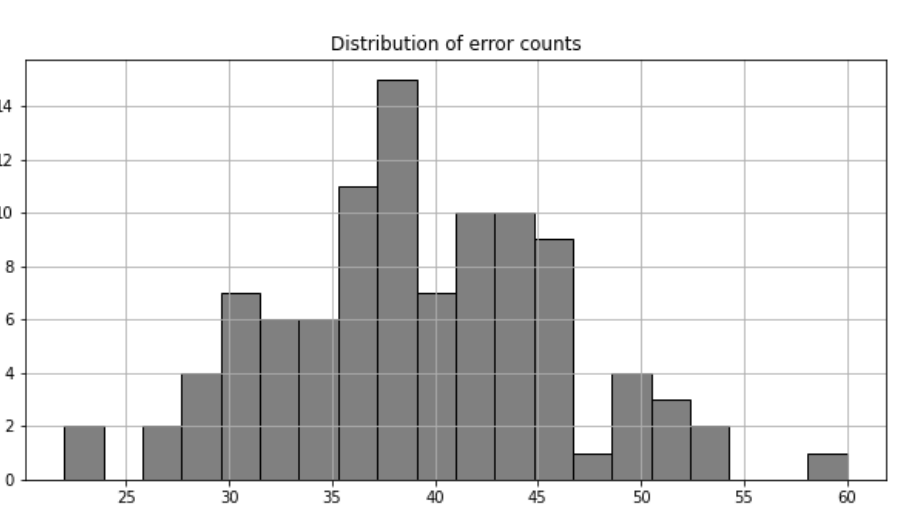
Figure 7. Relation between error statements, failures, and maintenance count. ( a ) The number of failures; ( b ) the number of maintenances.